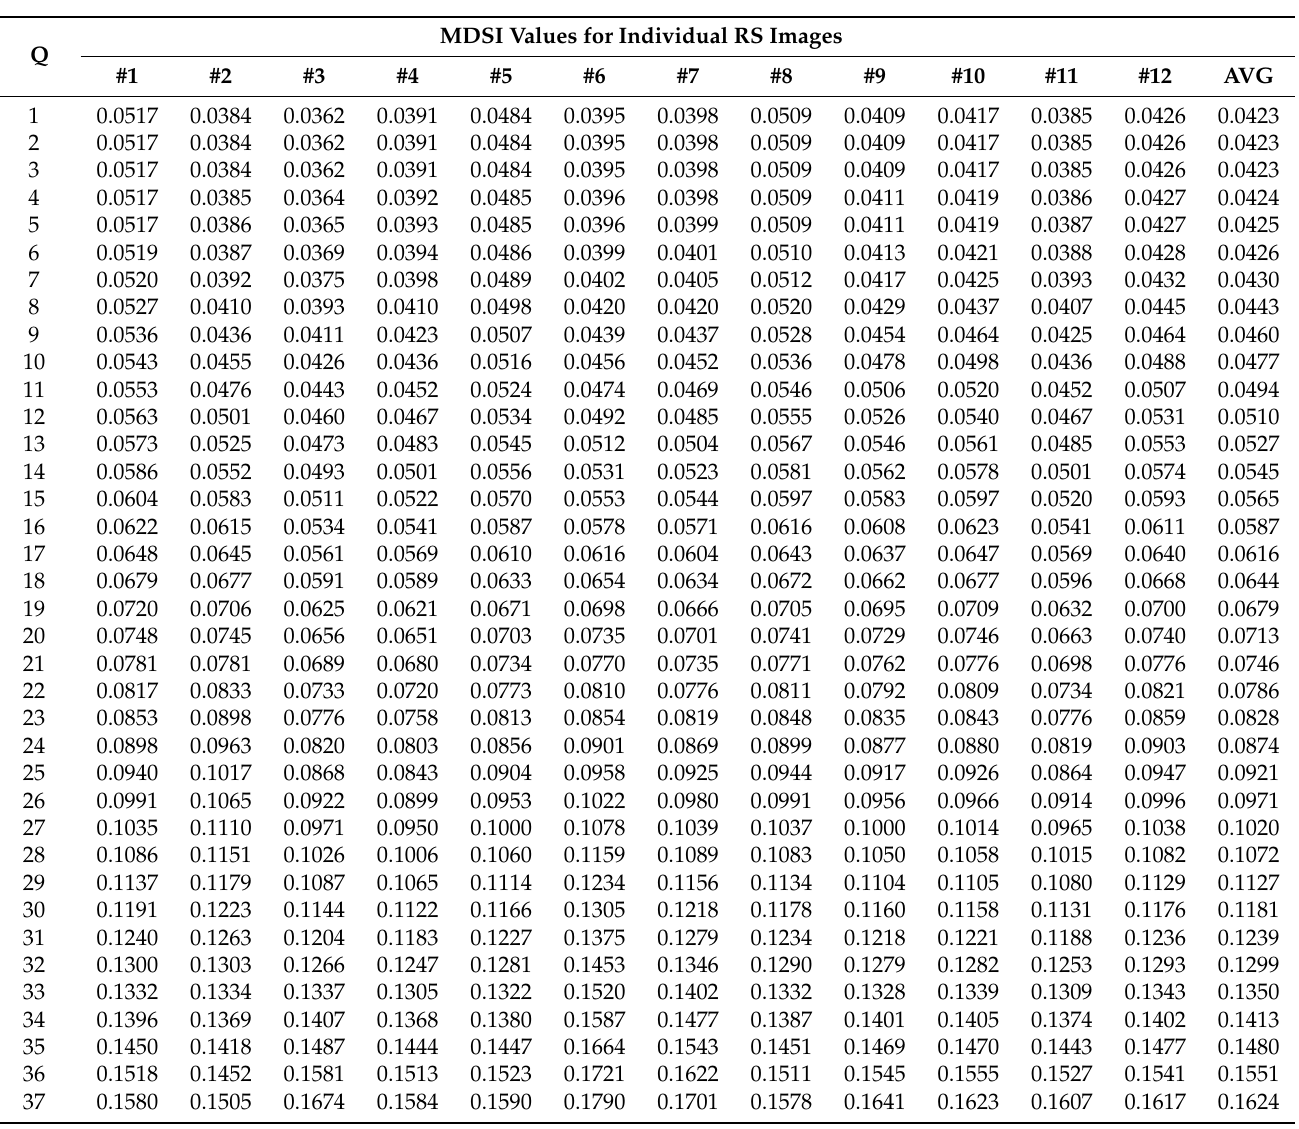
Table A2. The experimental data obtained for the basic image